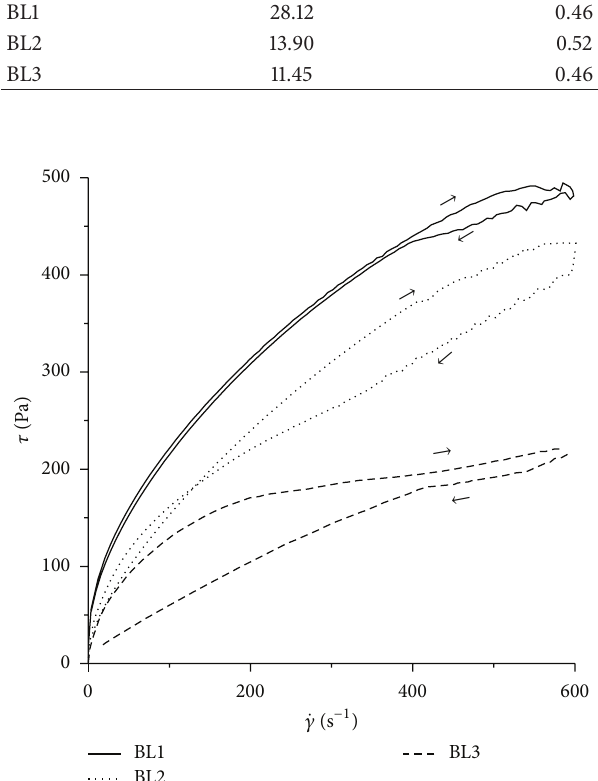
Figure 1: The flow curves of BL1, BL2, and BL3 in the range of shear rate 10 −2 –600 s −1 .